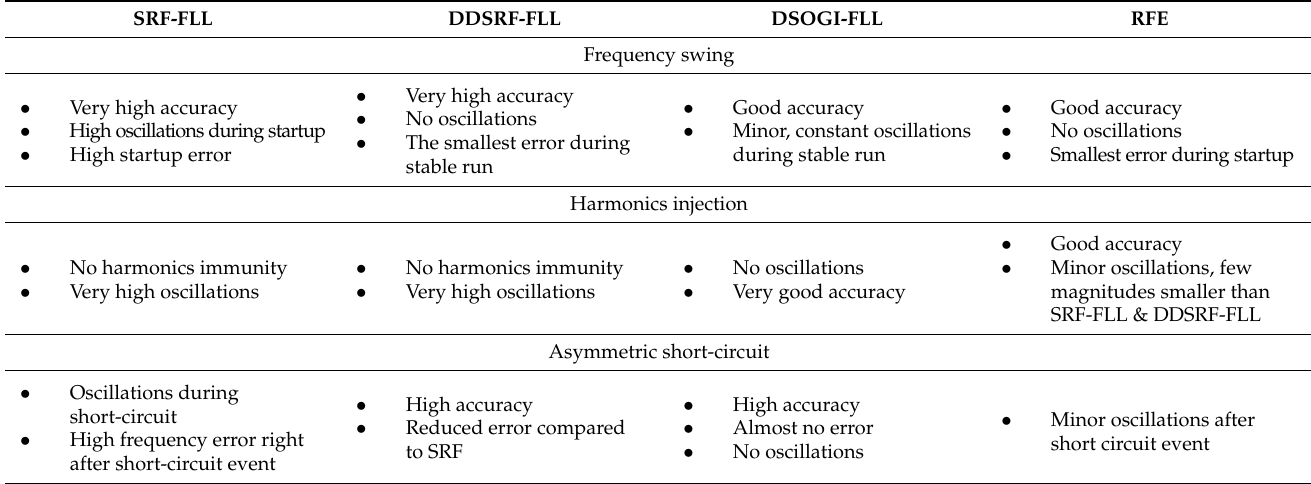
Table 1. Comparison of four frequency estimation